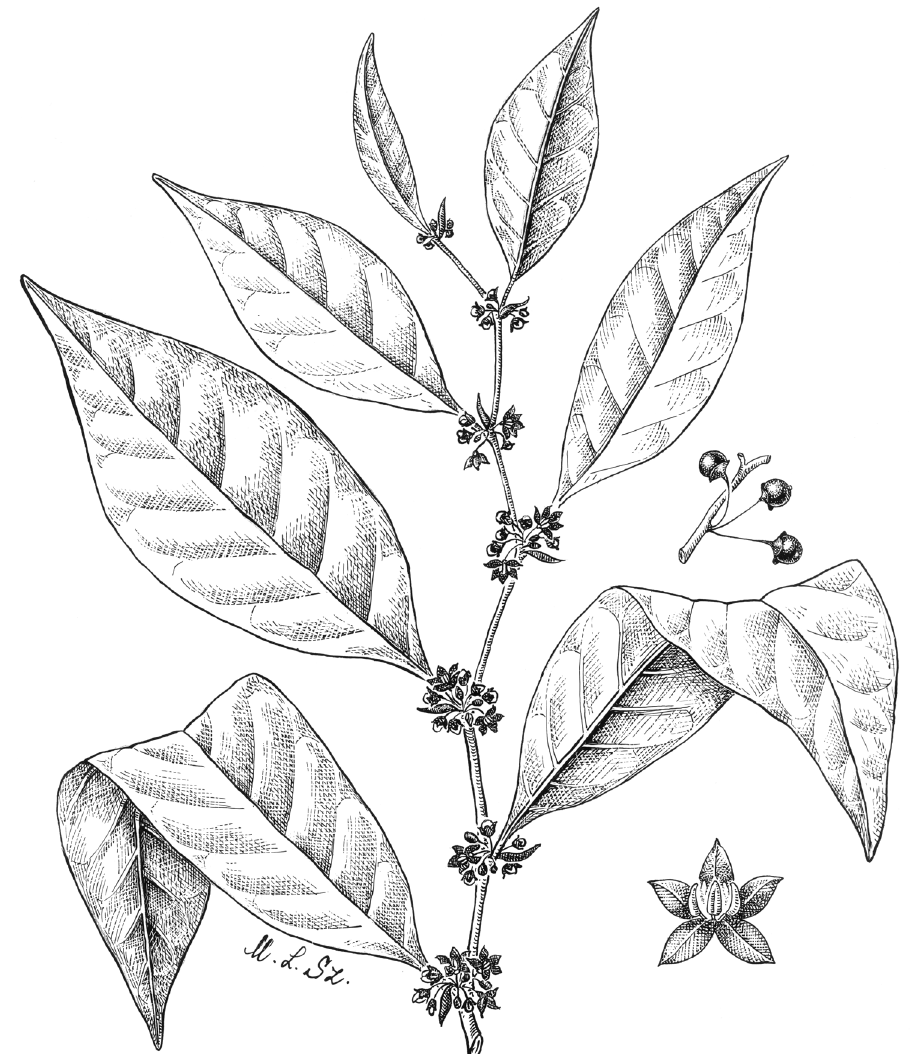
Figure 4. Lycianthes bambusarum (Bitter) Bitter. Drawing by M.L. Szent-Ivany, first published in Symon (1985: fig. 23, as S. umbonatum Symon). Courtesy of the Board of the Botanic Gardens and State Her- barium (Adelaide, South Australia), reproduced with